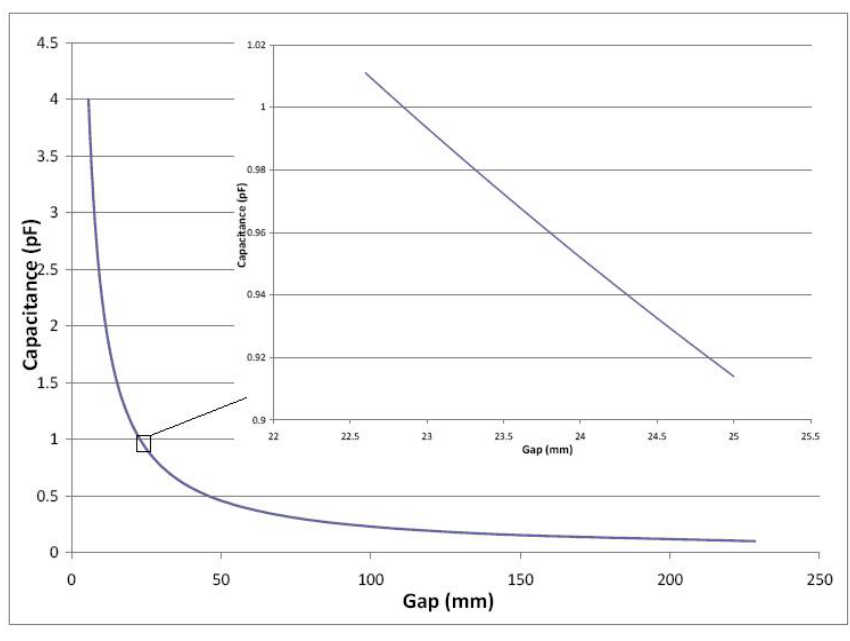
Figure 6. Capacitance vs. deflection relation for the sensor